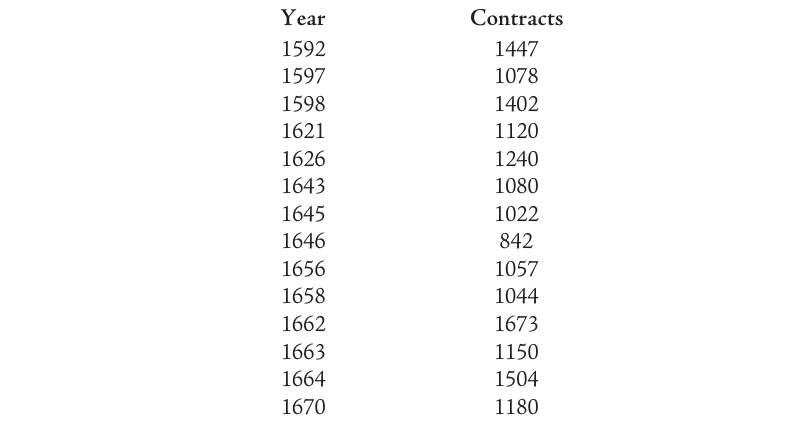
Table 4 – Number of Contracts of